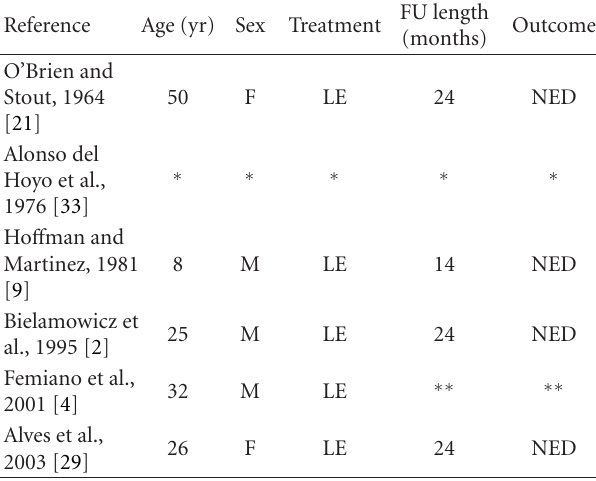
Table 1: Buccal mucosa BFH: review of the literature.